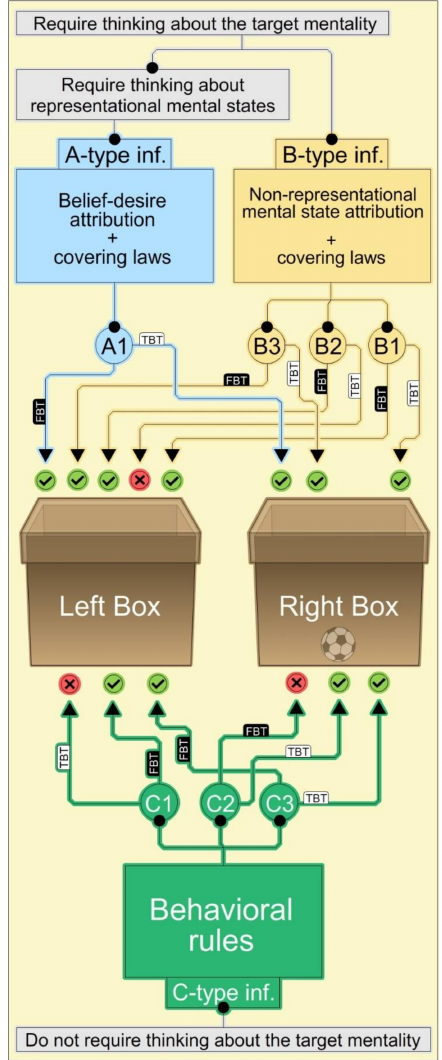
Figure 3. Predictive results of each